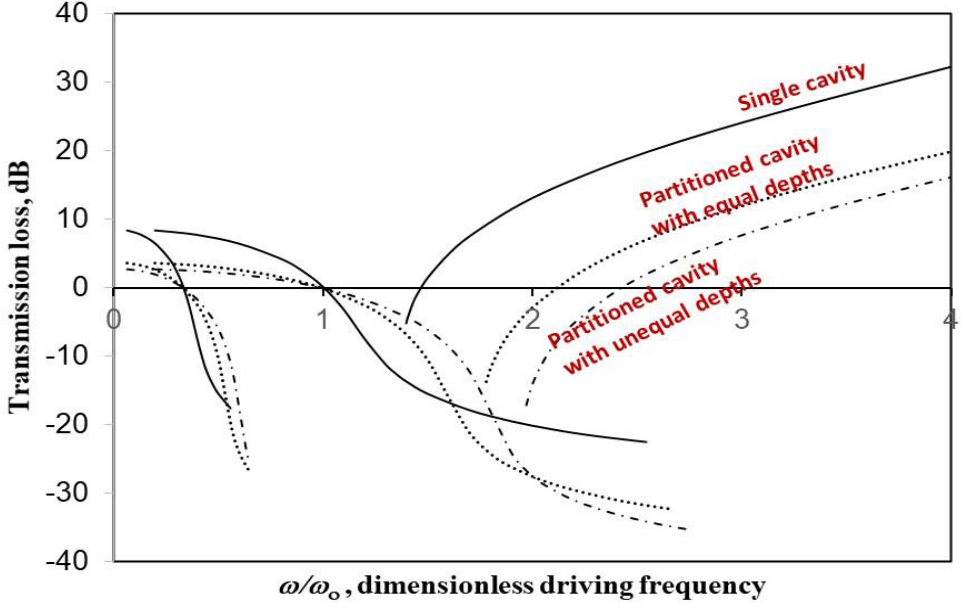
Figure 8. Transmission loss versus excitation frequency for various cavity cases ( c/a = 0.5, k = 5, ξ =